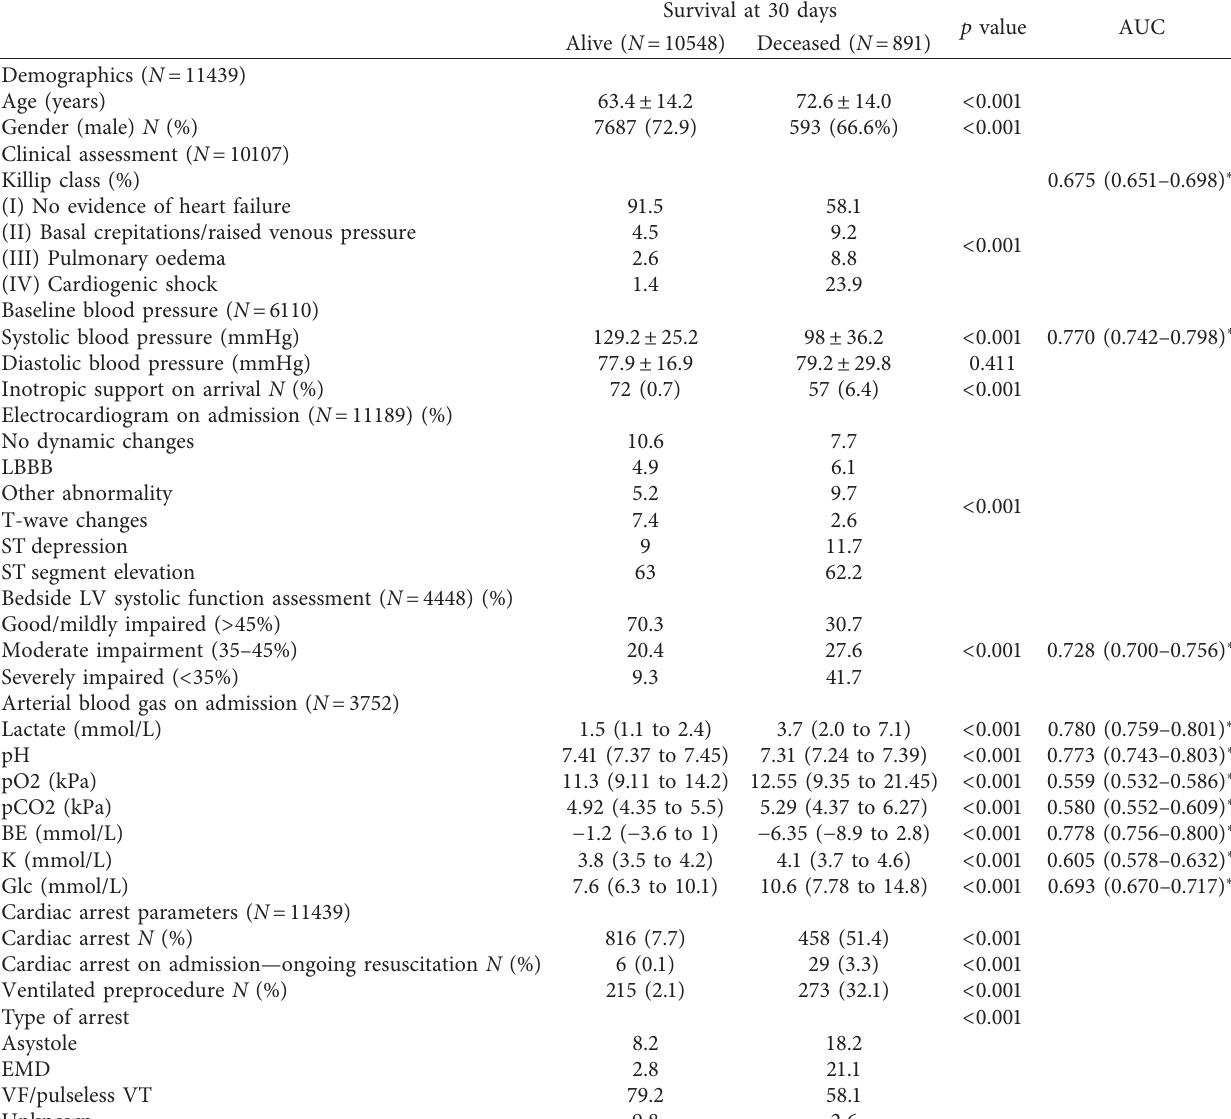
Table 4: Frontline variables in ACS patients grouped by vital status at 30